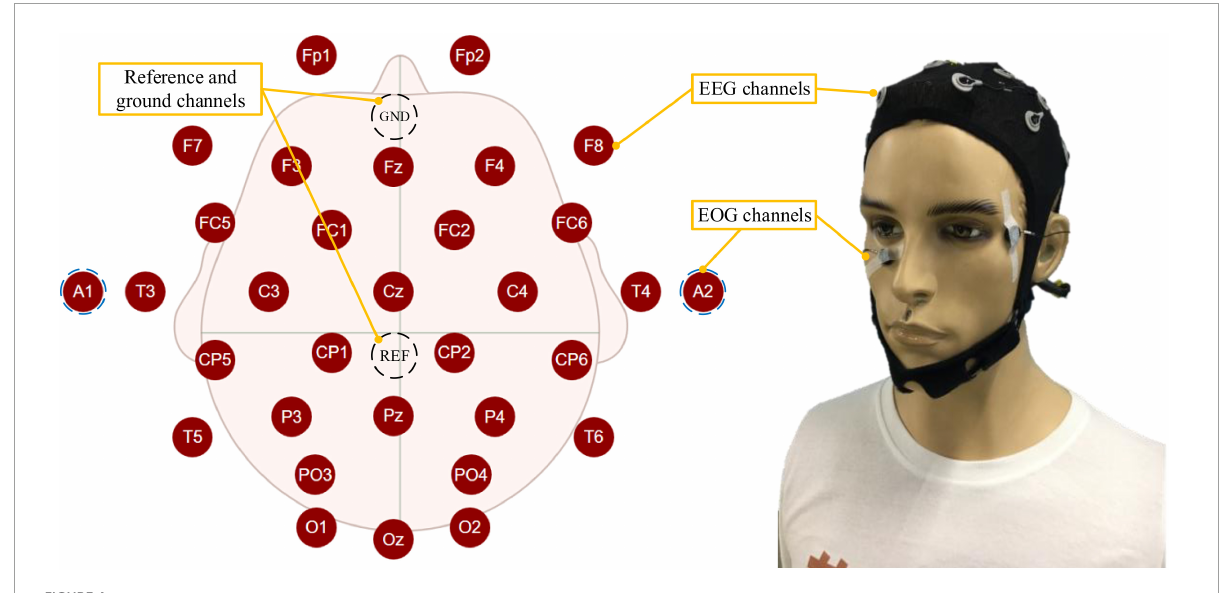
FIGURE4 The figure shows the distribution of EEG and EOG electrodes and how the participant wore them.